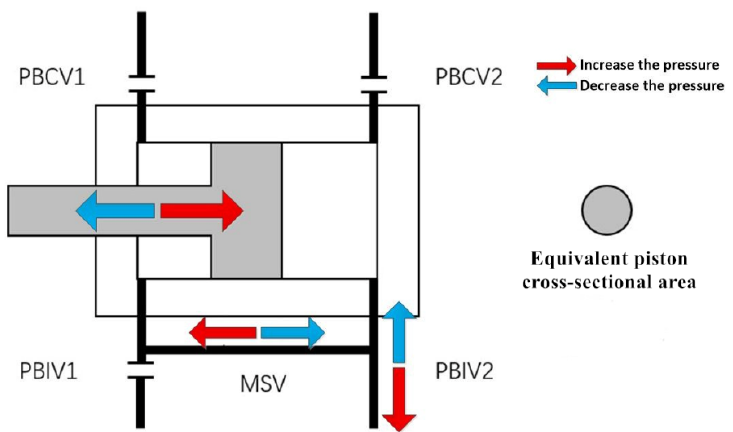
Figure 5. The flow direction of brake fluid and the action of solenoid valves under high pressure mode.